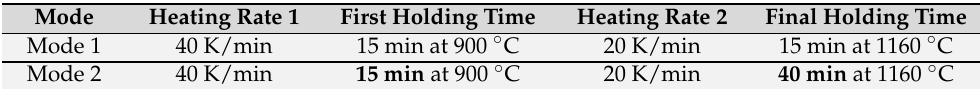
Table 2. Brazing process parameters.